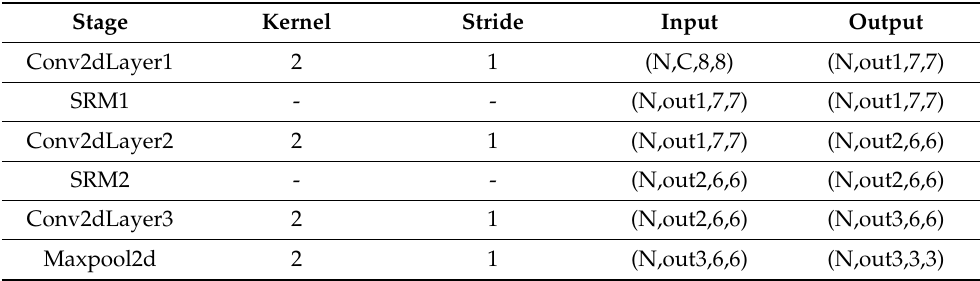
Figure 3. Framework diagram of convolutional layers based on SRM. Table 1. Parameters of the convolutional layer based on SRM.